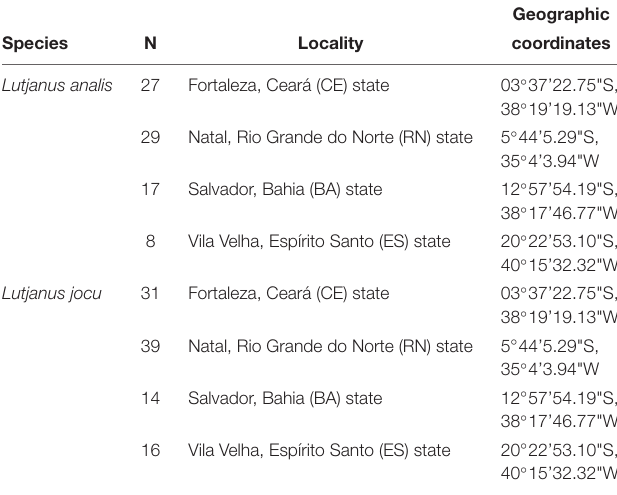
TABLE 1 | Collection sites of Lutjanus jocu and Lutjanus analis individuals along the Brazilian coast.